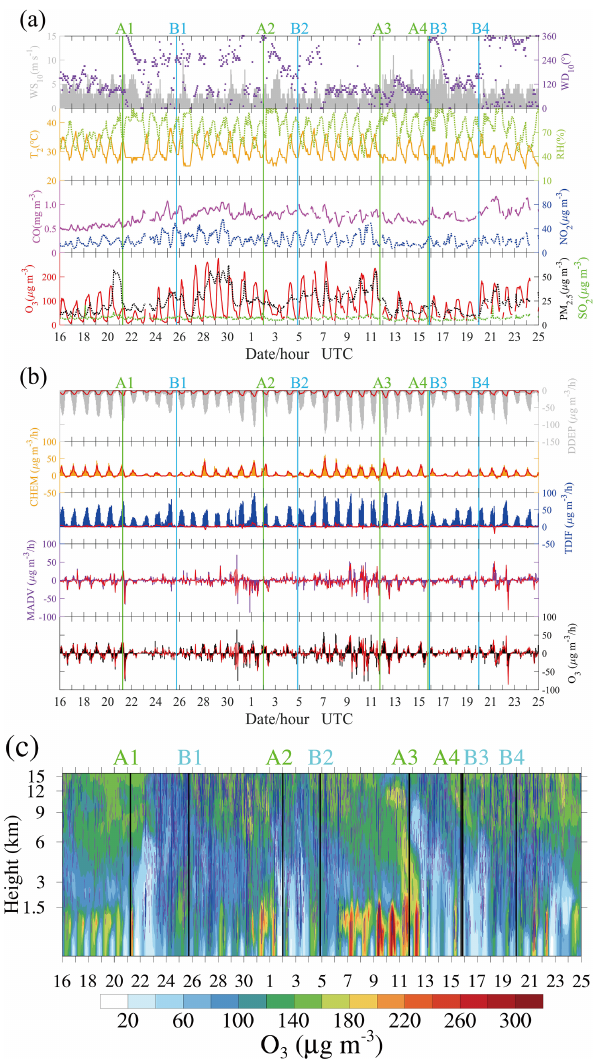
Figure 8. Same as Fig. 6a–c but for Hangzhou.